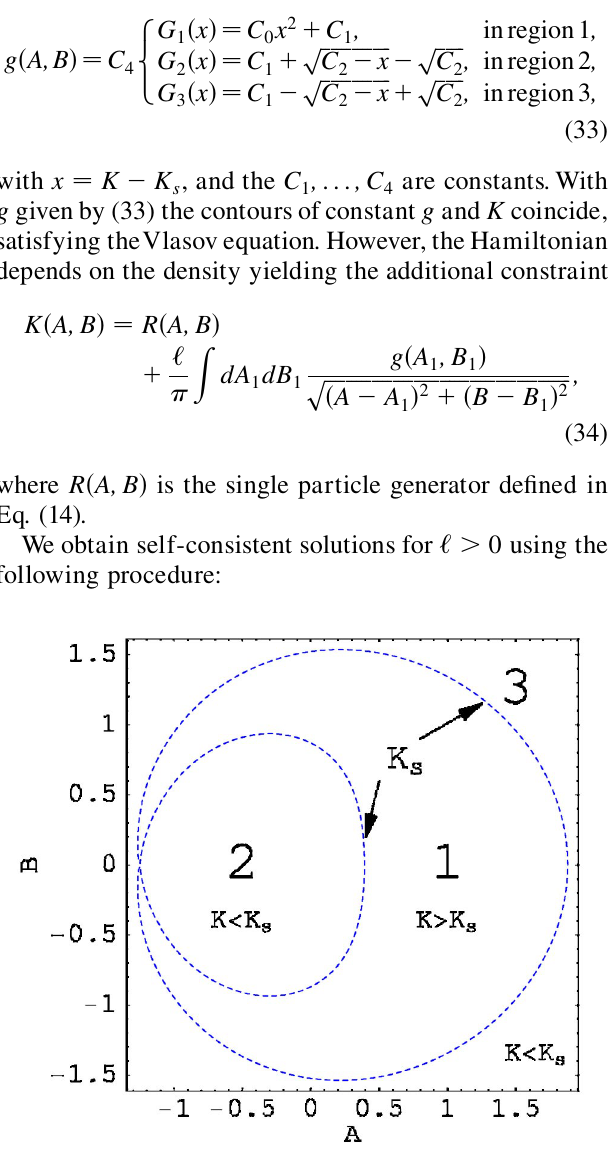
FIG. 10. (Color) Schematic contour plot of K (cid:3) A; B (cid:4) with ‘ > 0 and a soliton present. The dashed line represents the separatrix, K (cid:1) K . The particles are divided into three different groups: s particles that belong to the soliton (region 1), particles inside the inner separatrix (region 2), and particles outside the outer separatrix (region 3).